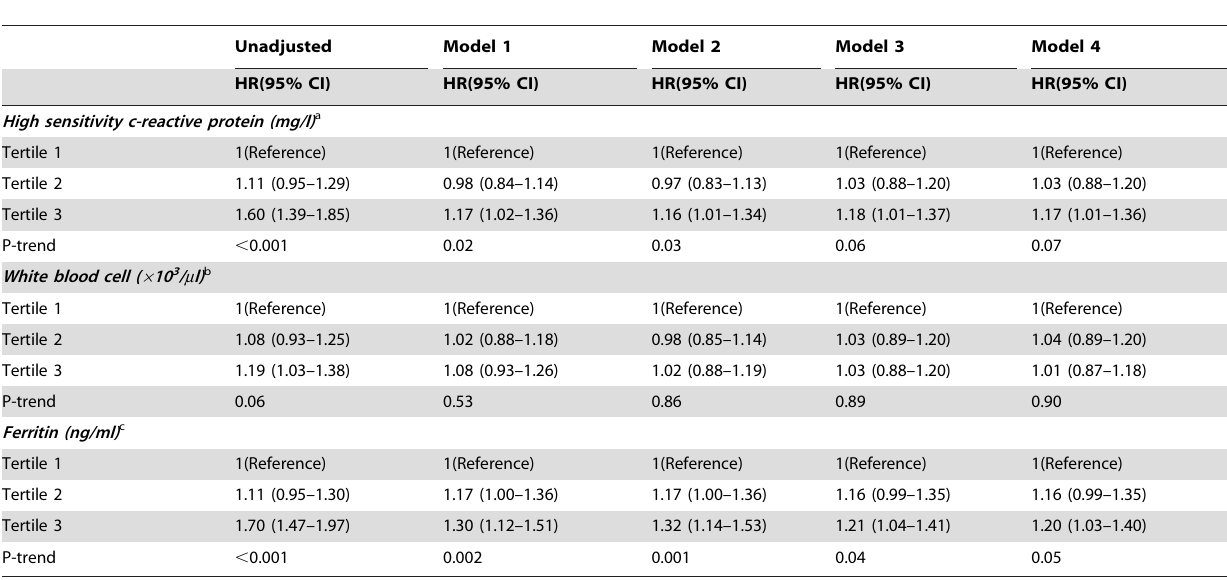
Table 3. Cox proportional hazards regression analysis of risks for renal replacement treatment among different inflammation markers